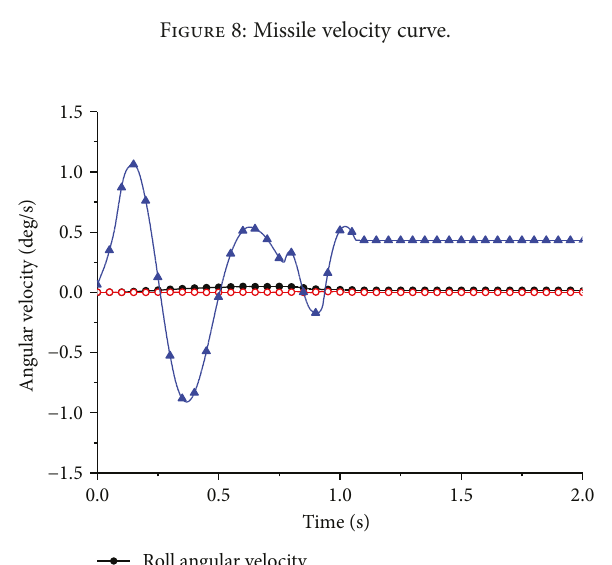
Figure 8: Missile velocity curve.